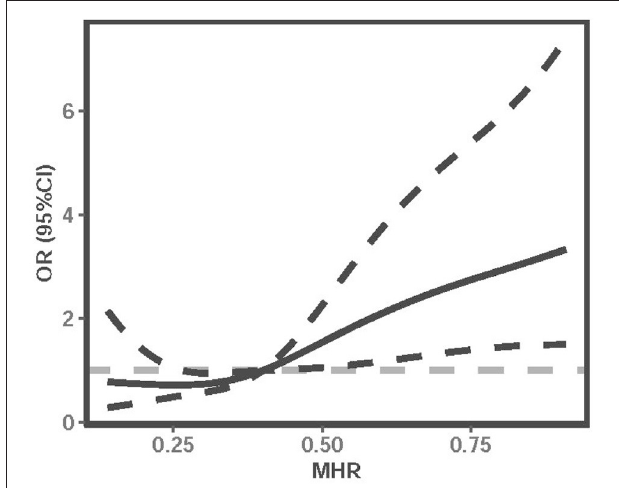
FIGURE 2 | Multivariable-adjusted RCS analysis with four knots (at the 5th, 35th, 65h, 95th percentiles) was performed to explore the association between MHR and the risk of poor outcome of LAA ischemic stroke. It was adjusted for age, gender, history of smoking, history of drinking, hypertension, diabetes mellitus, NIHSS, WBC, neutrophil, lymphocyte, FBG, triglyceride, HDL, nosocomial infection, and DVT. The solid line indicates adjusted ORs, and the dotted line indicates 95%CIs. RCS, restricted cubic spline; OR, odds ratio; CI, confidence interval; MHR, monocyte to high-density lipoprotein ratio; NIHSS, National Institutes of Health Stroke Scale; WBC, white blood cell; FBG, fasting blood glucose; HDL, high-density lipoprotein; DVT, deep vein